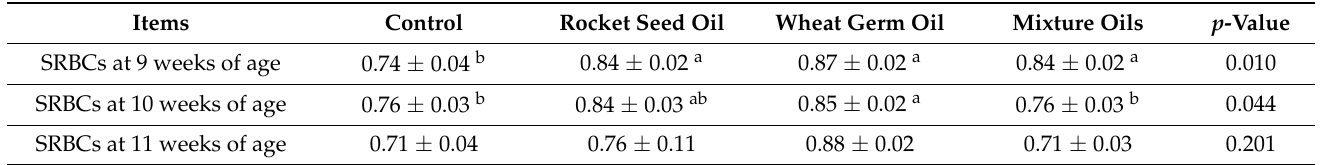
Table 6. Antibody titers against SRBCs of V-line growing rabbits (5–12 weeks of age) that were administered orally with rocket seed oil, wheat germ oil, and their mixture.